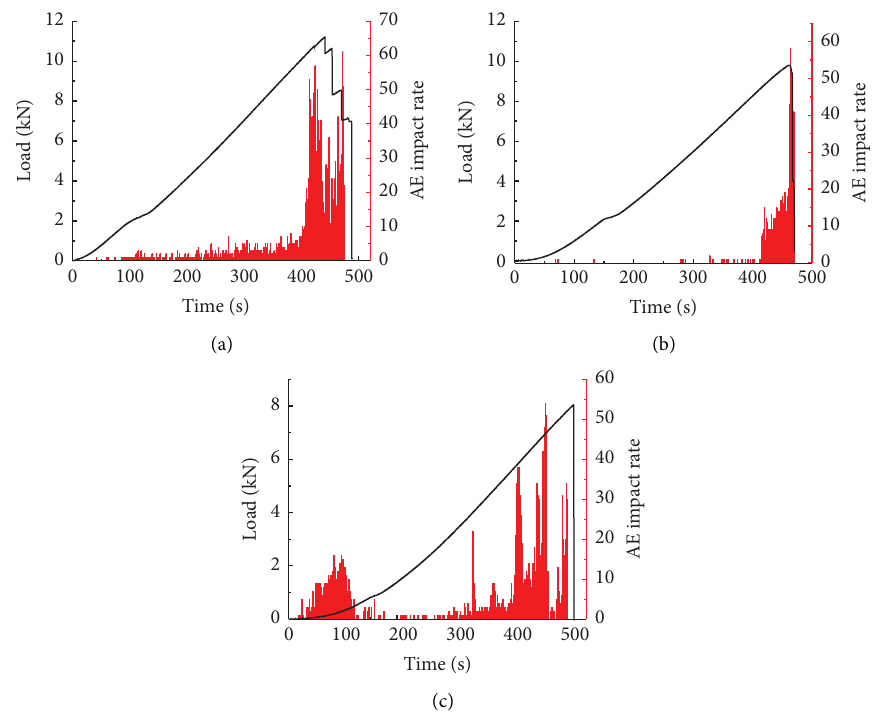
Figure 5: Evolution of coal sample AE impact rate: (a) N1; (b) NF1; (c)